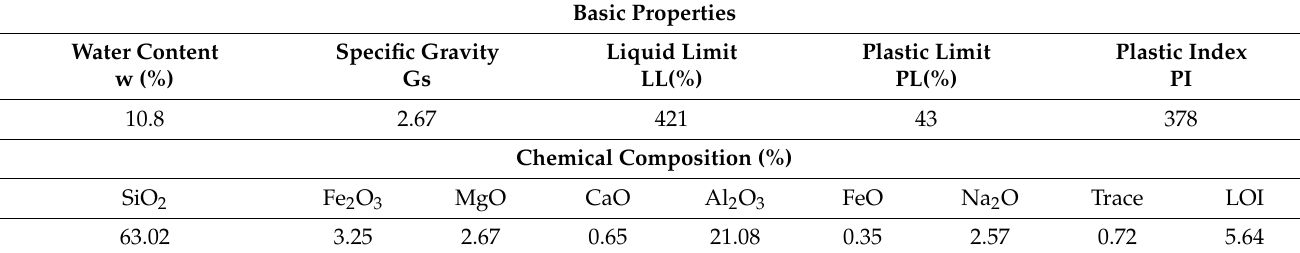
Table 1. Basic properties and chemical composition of SPV200